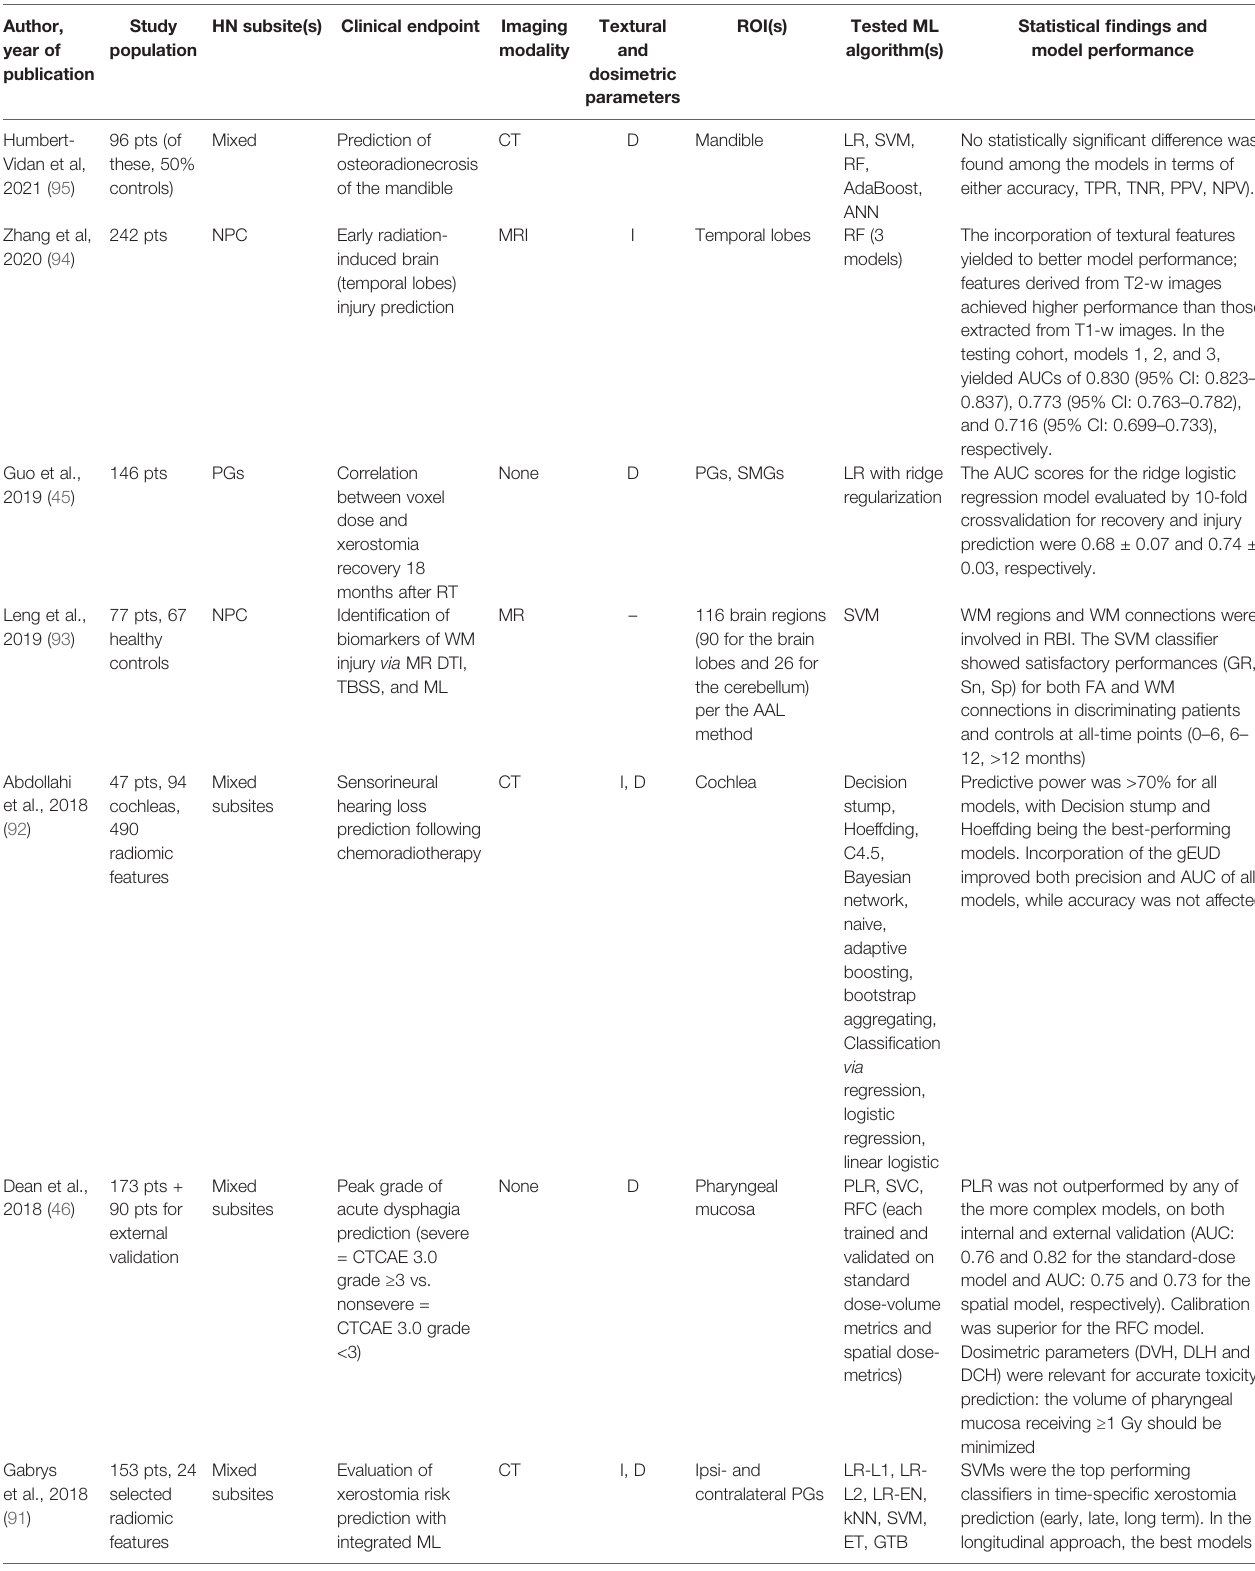
TABLE 5 | Characteristics for machine learning studies on toxicity